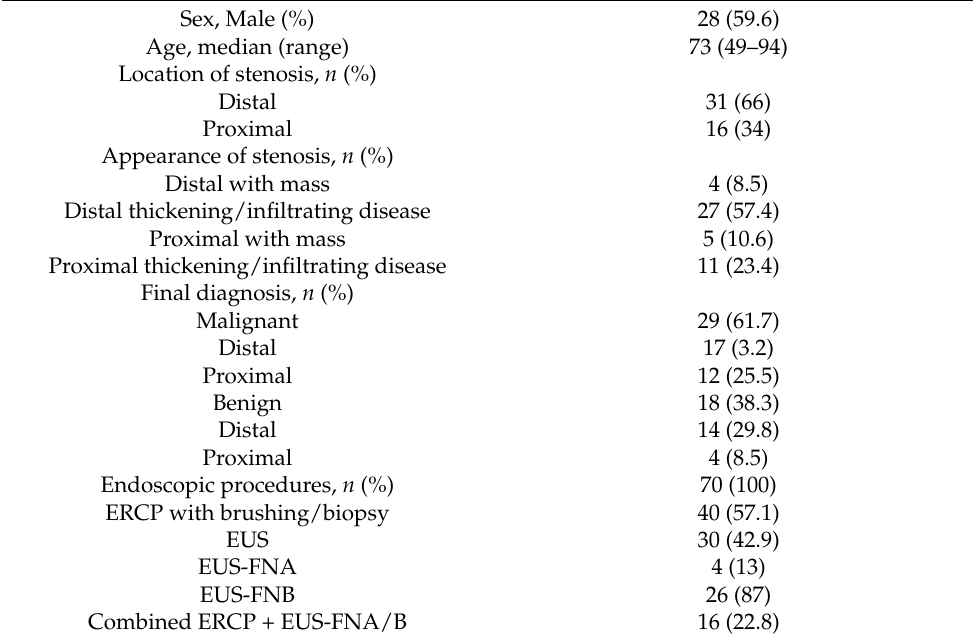
Table 1. Characteristics of 47 patients undergoing endoscopic procedures for biliary